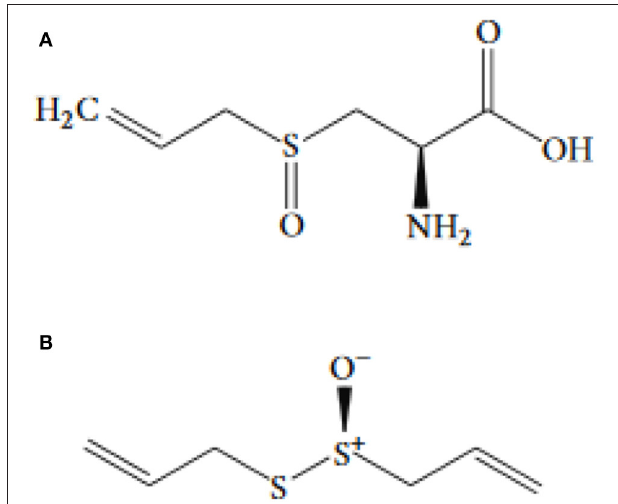
FIGURE 1 | The chemical structure of (A) allicin and (B)